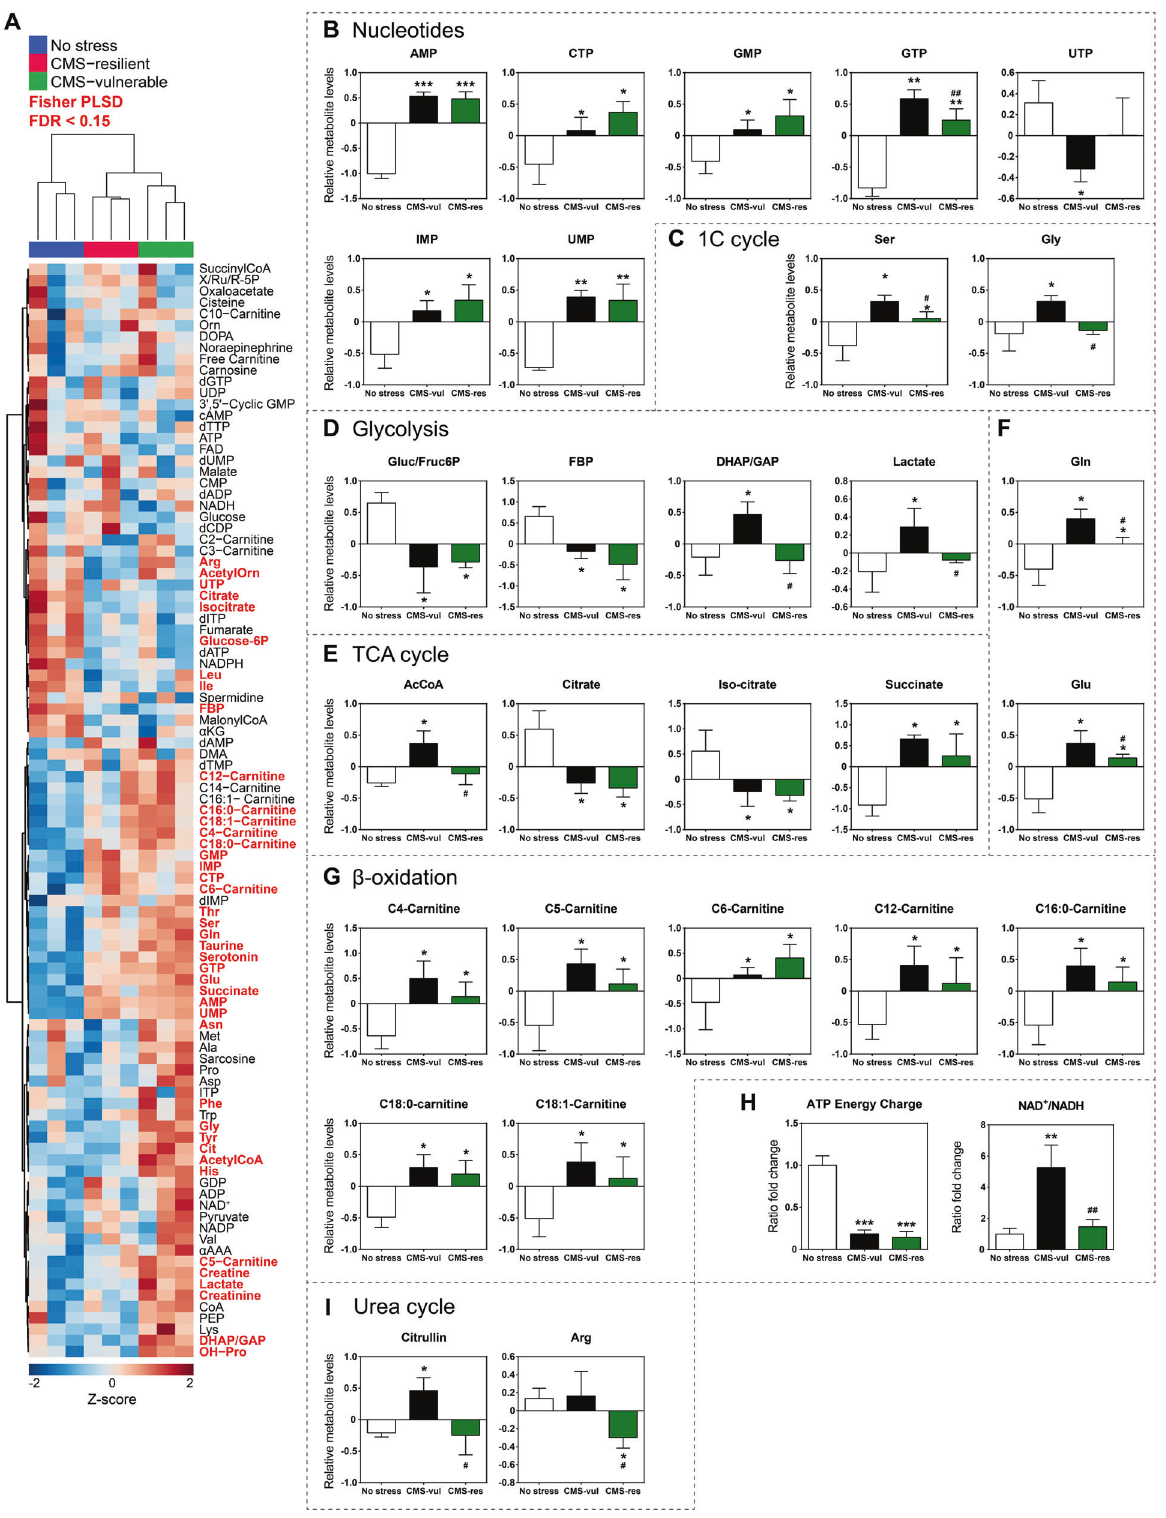
Fig. 3 Metabolite levels in the vHip of rats exposed to CMS. A Heatmap representing all analyzed metabolites by targeted LC-MS/MS metabolomics. Metabolites highlighted in red were statistically signi fi cant with a FDR < 0.15; B relative levels of several mono-, di, and triphosphate nucleotides (NTPs), C relative levels of 1C cycle intermediates, D relative levels of glycolysis metabolites, E relative levels of TCA cycle intermediates, F relative levels of glutamine and glutamate, G relative levels of acylcarnitines, H fold change of ATP energy charge and NAD + /NADH ratio, panel I : relative levels of urea cycle intermediates in control (no stress) or stressed (CMS-vul/CMS-res) animals. B – G , I : the data are the mean ± SD. *FDR < 0.05, **FDR < 0.01, ***FDR < 0.001 vs no stress; # FDR < 0.05, ## FDR < 0.01 vs CMS-vul (one-way ANOVA, Fisher ’ s PLSD). H mean ± SEM. **FDR < 0.01, **FDR < 0.001 vs no stress; ## FDR < 0.01 vs CMS-vul (one-way ANOVA, Fisher ’ s